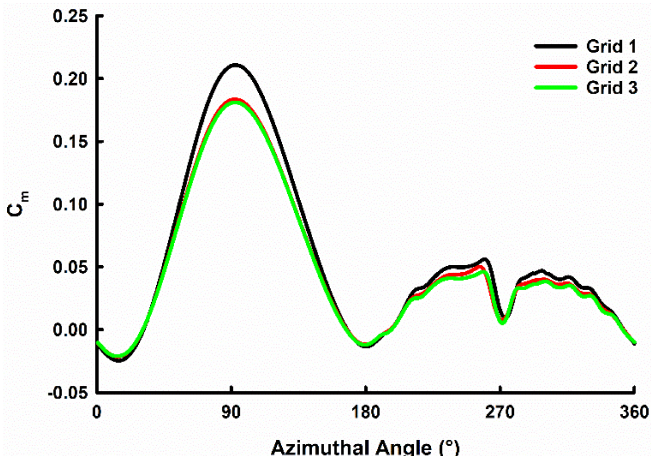
Figure 5. Grid independence study conducted using three different grid